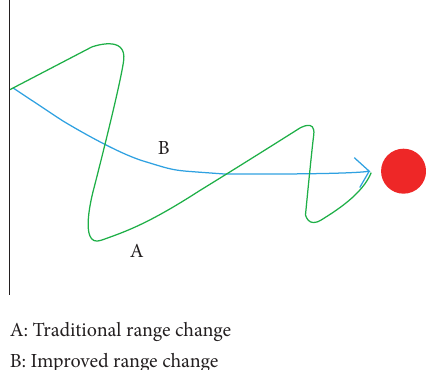
Figure 2: Traditional and improved range